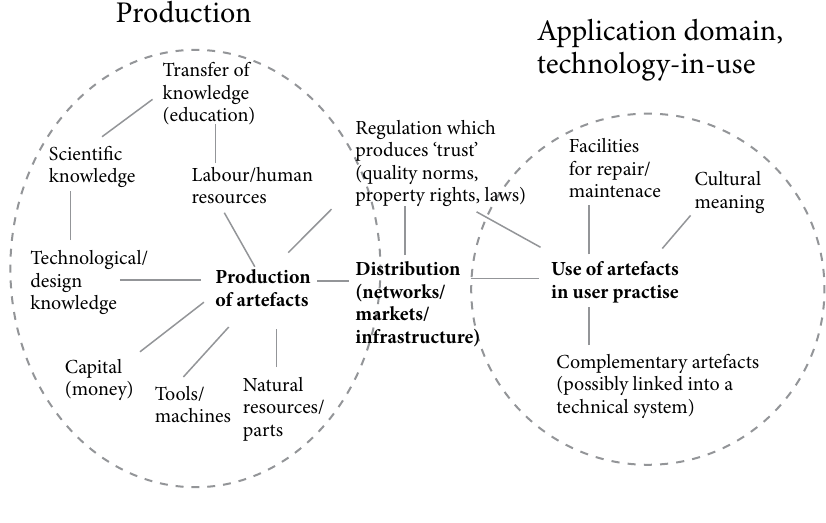
Fig. 4. The basic elements and resources of socio-technical systems (Geels